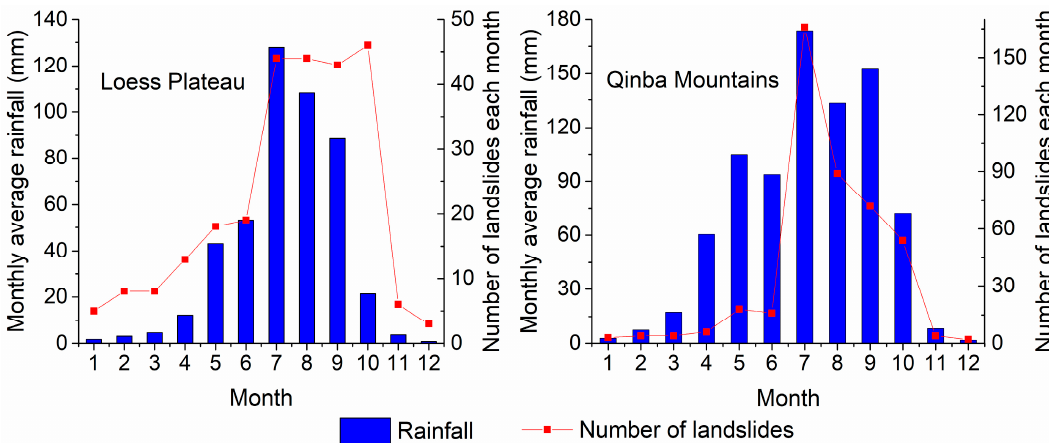
Figure 8. Monthly distribution of landslides and rainfall.